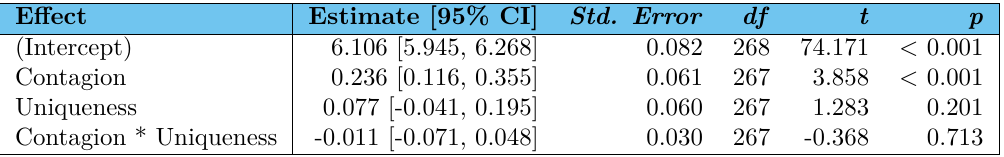
Table 1. Parameter Estimates for the Linear Mixed Model in Study